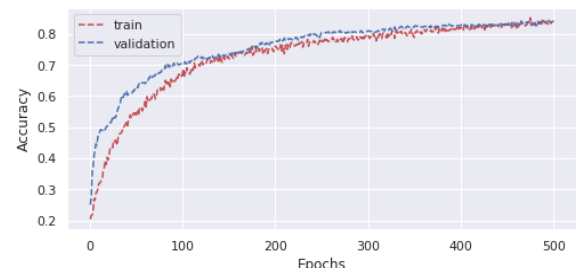
Figure 3. Accuracy of the training and the validation data during the training process of the proposed